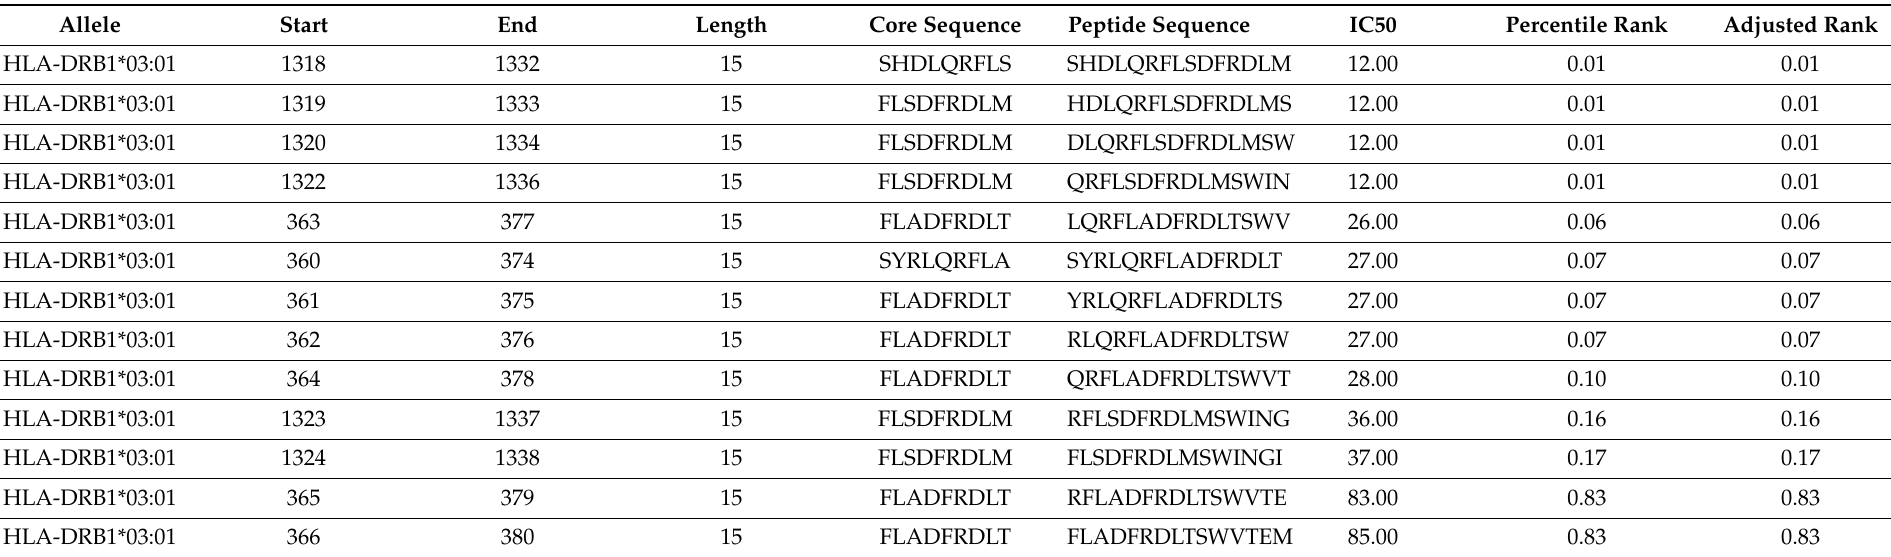
Table 8. HLA-DR3 allele with predicted peptides of human α